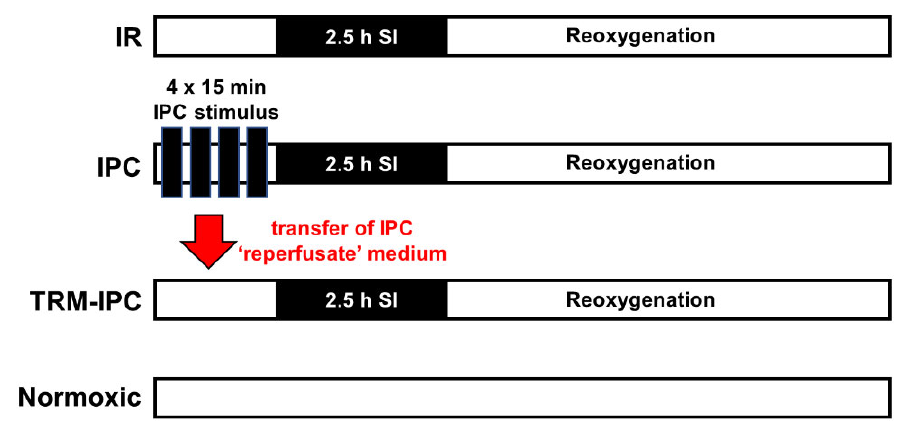
Figure 1. Timelines for IR, IPC, TRM-IPC and time-matched normoxic control groups. In Protocols 1 and 2A: HL-1 cells were cultured for 48 h before group assignments were made. Groups were reoxygenated for 24 h for the assessment of viability (Protocol 1), reoxygenated for 30 min for assessment of cytosolic expression of cytochrome c and cleaved caspase 3 (Protocol 1, Supplementary Material), or reoxygenated for 30 min for assessment of the subcellular distribution of OPA1 (Pro ‐ tocol 2A). In Protocol 3: the same 4 group assignments were made. However, for each group, (IR, IPC, TRM ‐ IPC, normoxic control), three transfection cohorts were assessed: cells were transfected with siRNA targeting OPA1, transfected with scrambled siRNA, or non ‐ transfected. IR = simulated ischemia ‐ reoxygenation, IPC = ischemic preconditioning, TRM ‐ IPC = transfer of IPC ‘reperfusate’ medium.